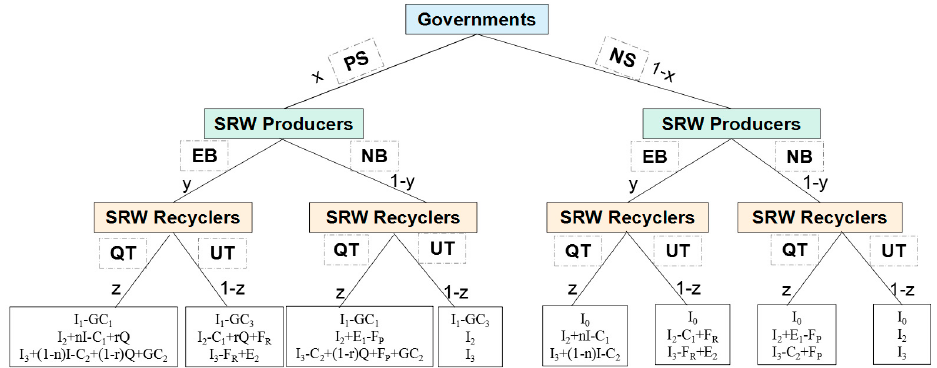
Figure 2. The three-party evolutionary game tree.